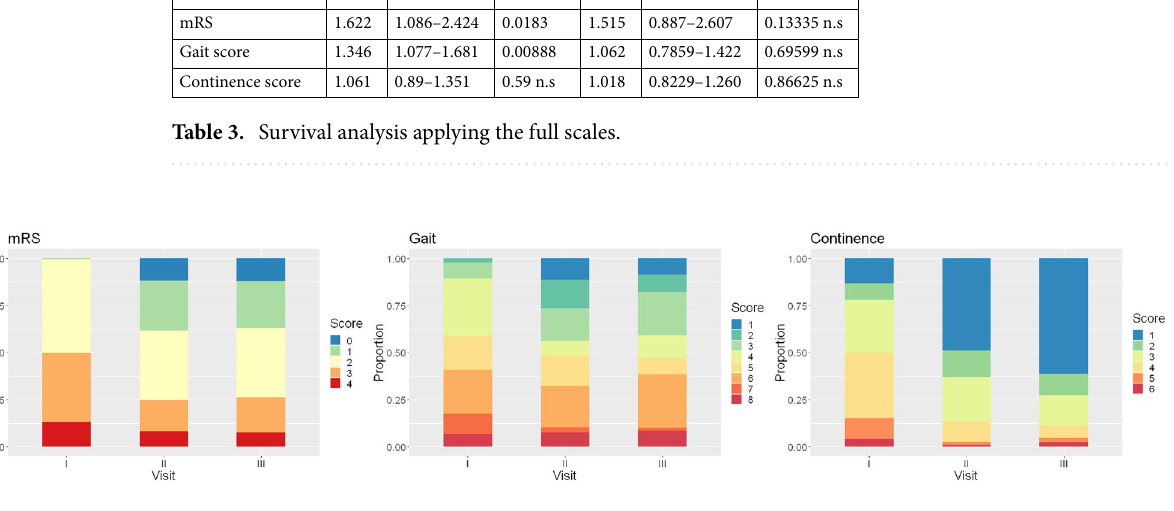
Figure 2. Stacked proportional bar graphs of mRS, gait and continence scores. Postoperative follow-up examinations show a significant improvement of the three categories. Yellow indicates moderate impairment, red and orange are worse, blue, and green are better.